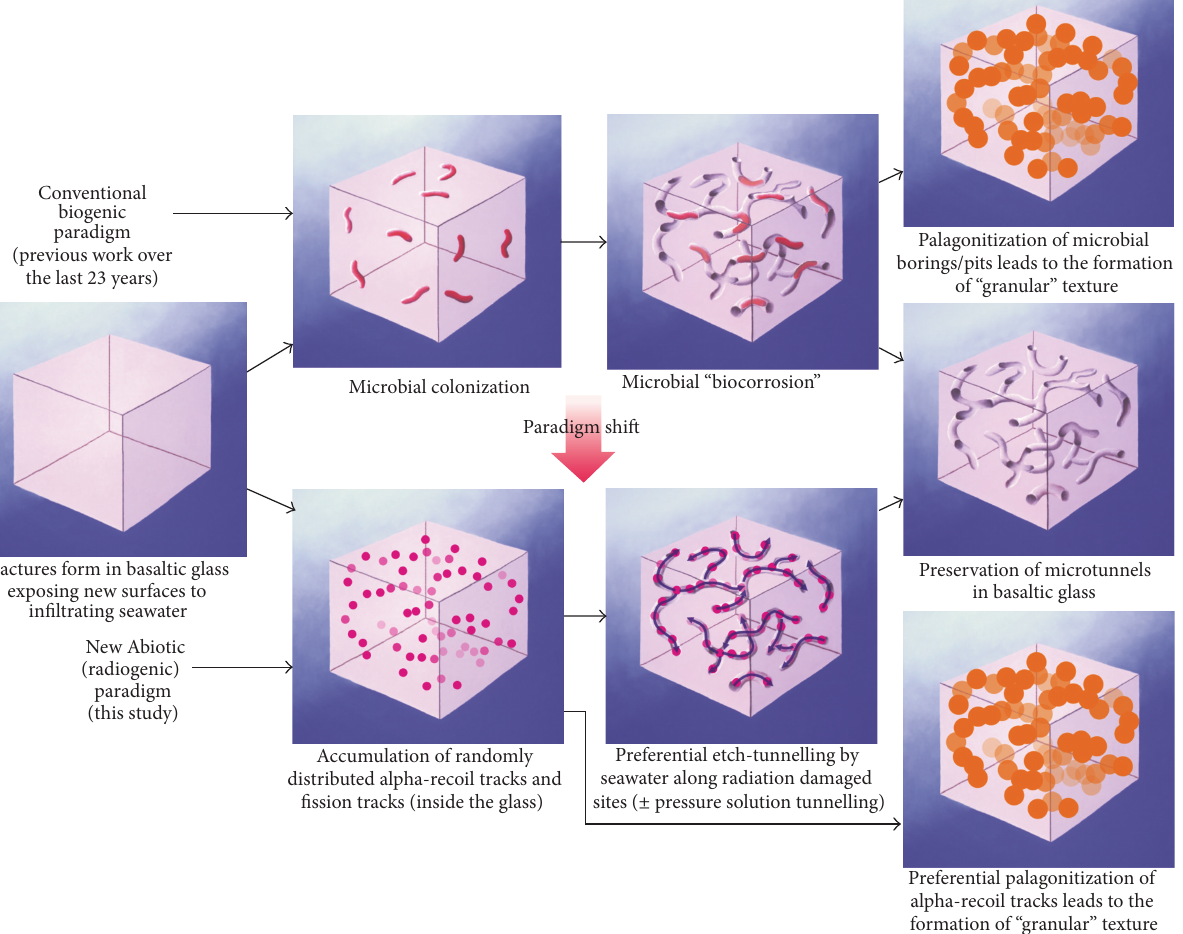
Figure 19: Diagram outlining a paradigm shift in scientific perspectives on the origin of complex corrosion microtextures in submarine basaltic glass—constrained in this study with our model for the preferential corrosion of radiation damage (by seawater) in basaltic glass pillow margins at DSDP 418A (i.e., new abiotic “Radiogenic” paradigm). The conventional “biogenic” paradigm is outlined in previous studies on microbial bioalteration of basaltic glass (e.g., see reviews in Furnes et al. [11], Furnes et al. [26], Staudigel et al. [27], McLoughlin et al. [28], and Furnes et al.